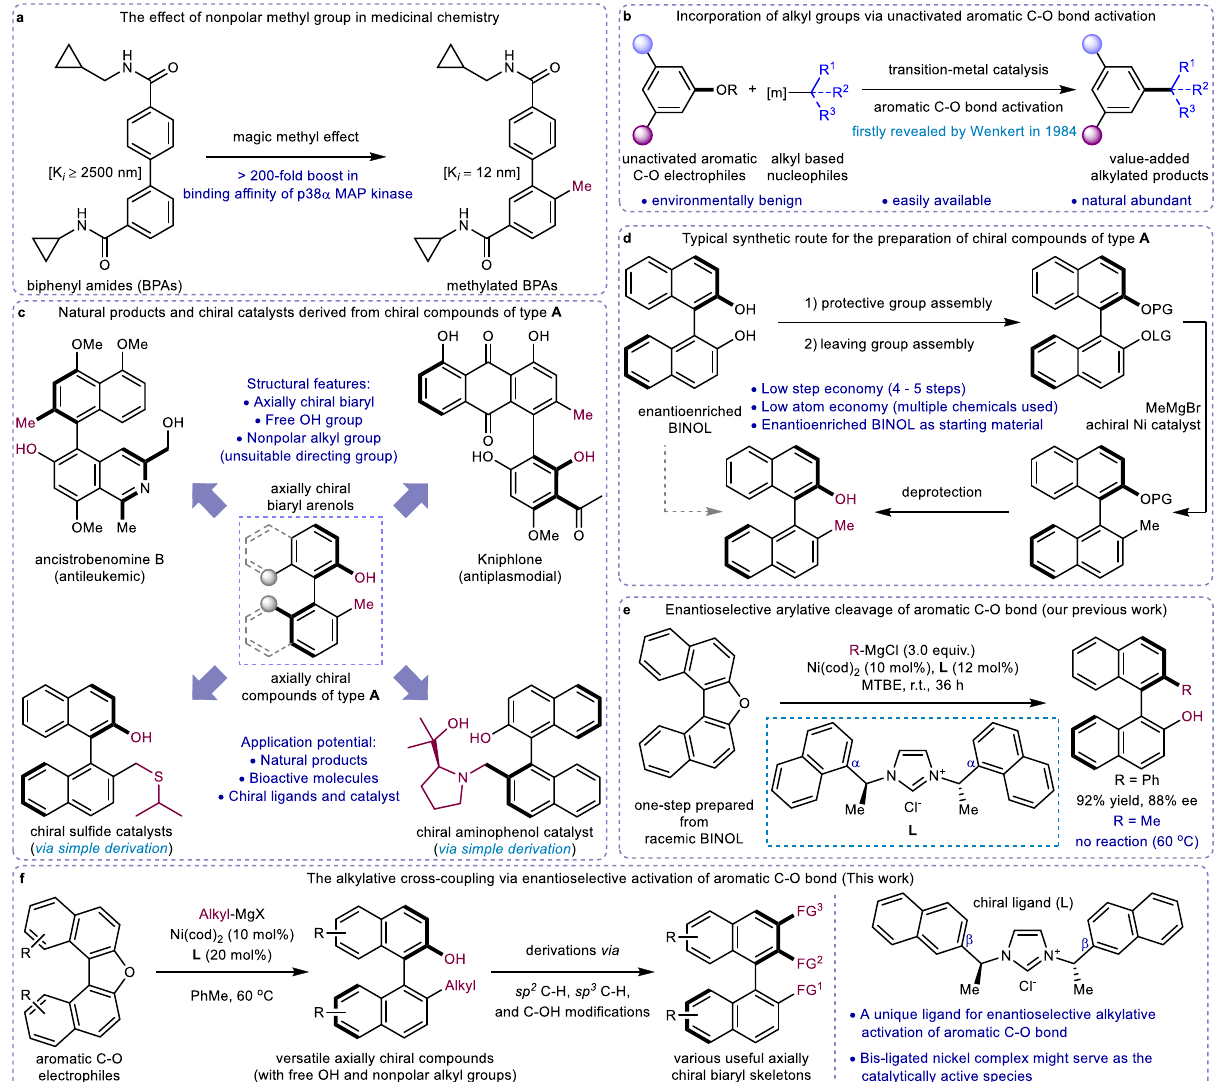
Fig. 1 Enantioselective C(sp 3 ) – C(sp 2 ) cross-coupling of unactivated aromatic C – O bond. a The effect of nonpolar methyl group in medicinal chemistry. b Incorporation of alkyl groups via unactivated aromatic C – O bond activation. c Natural products and chiral catalysts derived from chiral compounds of type A . d Typical synthetic route for the preparation of chiral compounds of type A . e Enantioselective arylative cleavage of aromatic C – O bond (our previous work). f This work: the alkylative cross-coupling via enantioselective activation of aromatic C – O bond. BINOL 1,1 ’ -bi-2-naphthol, PG protective group, LG leaving group, FG functional group, MTBE methyl tertbutyl